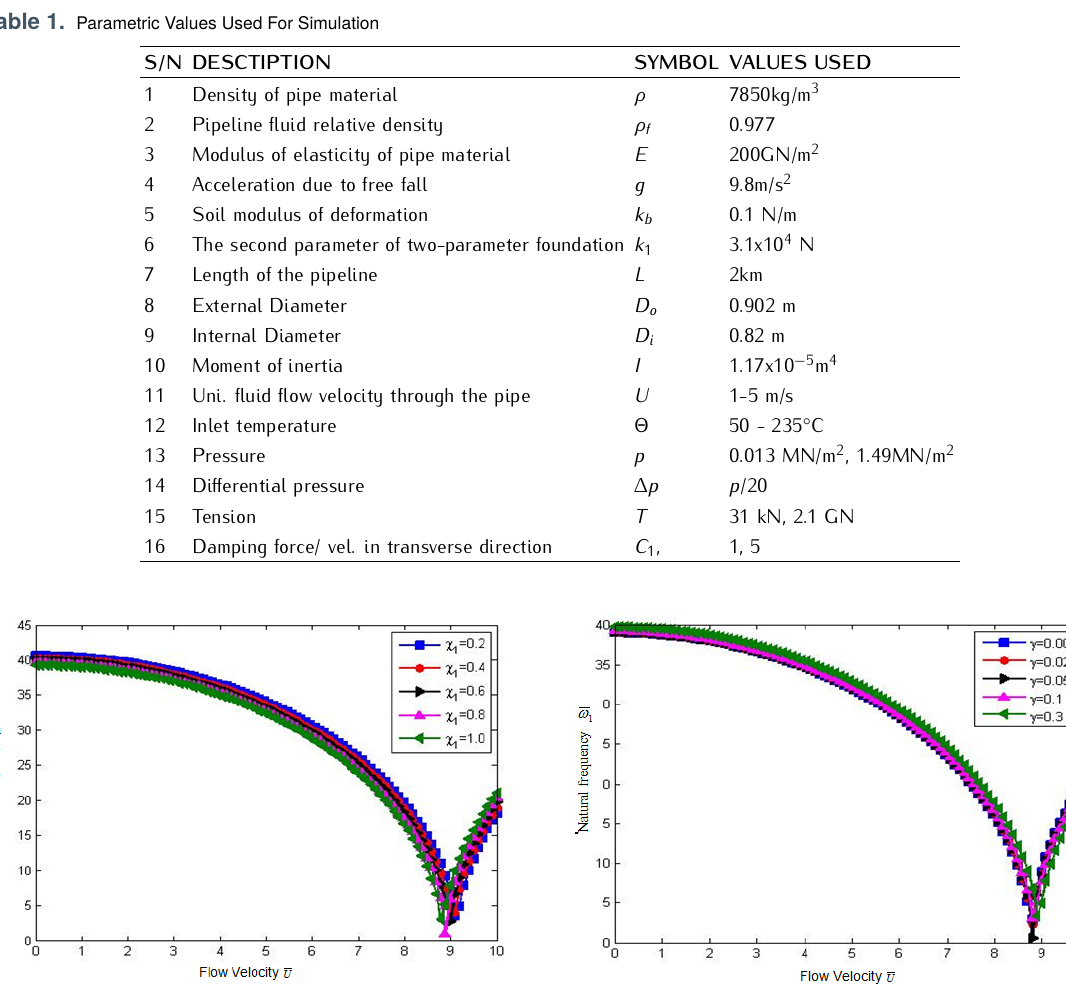
Figure 6. Absolute values of the transverse natural frequencies ¯ ω 1 profile for the case R i = 0 . 41 m,L = 2 km,n = 1 ,δ 1 = 0 . 3721 , Θ = 100 ◦ C,χ = − 0 .